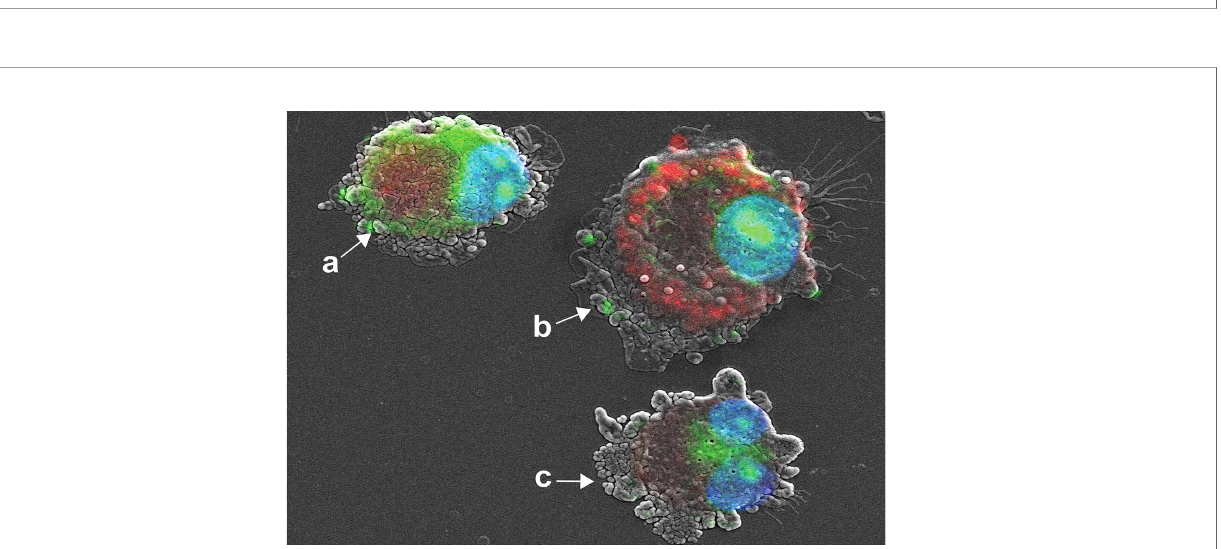
FIGURE 4 | Cytoplasmic transportation of YOYO-IL-4pDNA/NPs. Confocal microscopy and SEM images were taken of MDM transfected with YOYO-IL-4pDNA- NPs for co-imaging assay. Co-imaging of microstructural evaluation was used to determine the intracellular YOYO-IL-4pDNA-NPs escaping from LysoTracker labeled lysosomes (red) to enter the nucleus (blue). Co-imaging showed co-localization of YOYO-IL-4pDNA-NPs (a, green) with lysosomes (a, red) by MDM. YOYO-IL- 4pDNA-NPs escaped from lysosomes (b, red) , resulting in the separation of “ red ” lysosomes and “ green ” YOYO-IL-4pDNA. The escaped YOYO-IL-4pDNA-NPs (c, green) from lysosomes were transported into the nucleus (blue).